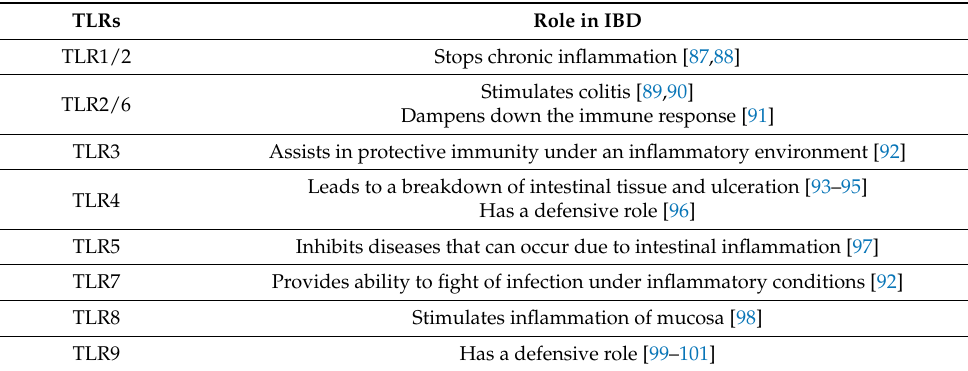
Table 5. Role of TLRs in IBD. (Adapted from Lu et al., 2018 [83]).